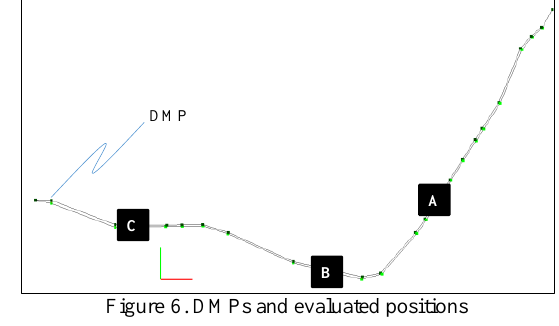
Figure 4. MMS point clouds and trajectory